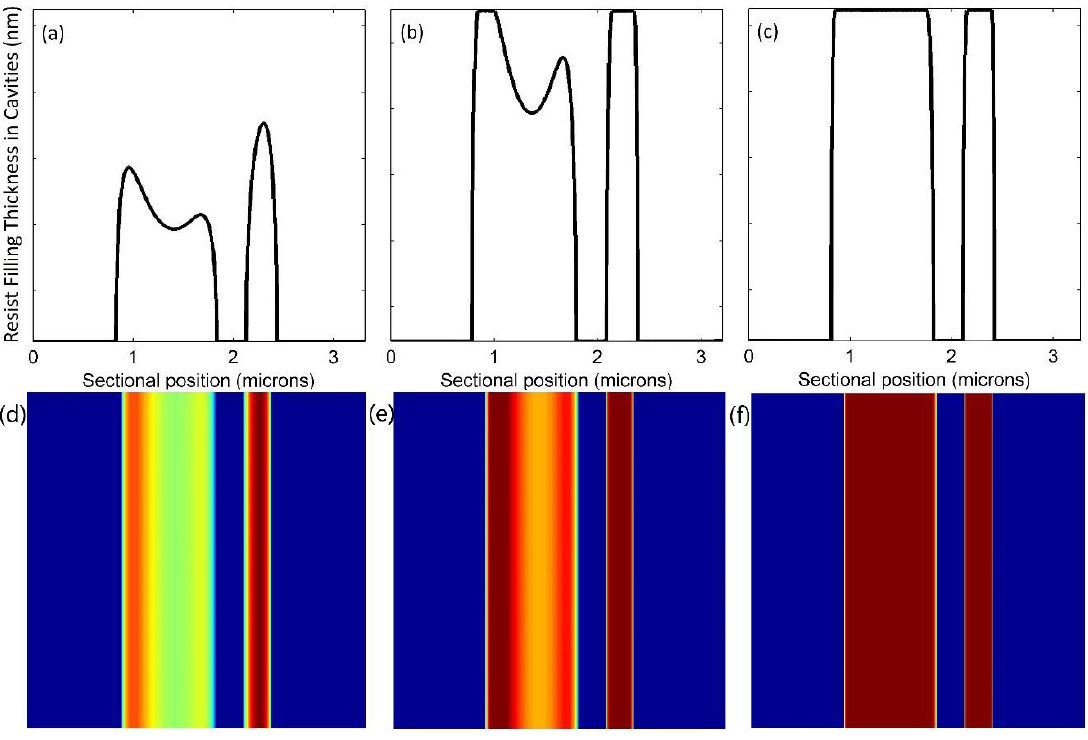
Figure 6. Profiles of resist filling in the neighboring micro-/nanoscale cavities at ( a ) 1.08 s; ( b ) 4.32 s; ( c ) 10.80 s and their corresponding top views at ( d ) 1.08 s; ( e ) 4.32 s, ( f ) 10.80 s.